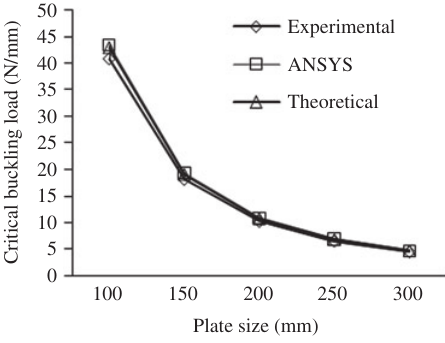
Figure 5 Comparison of the experimental, ANSYS and theoretical